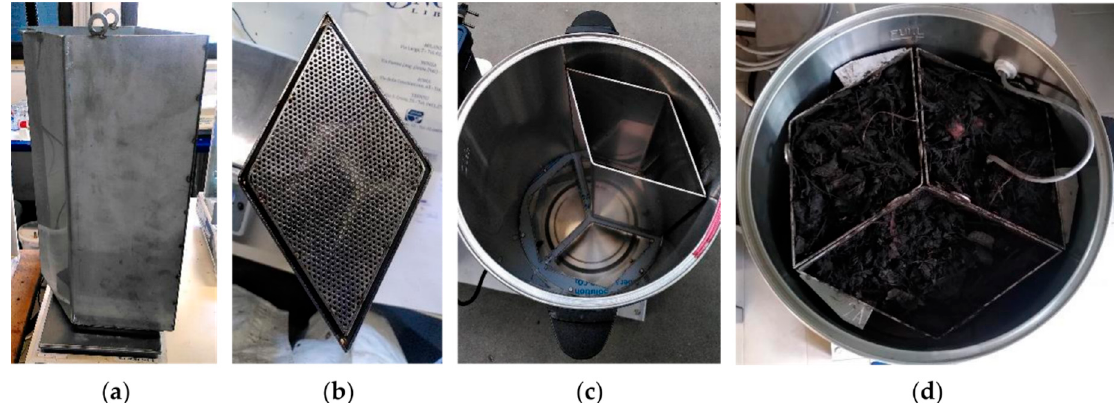
Figure 2. The internal rhombohedral sectors for triplicate co-composting test; ( a ) Lateral view of one sector; ( b ) Bottom view of the sector; ( c ) One sector put on the internal support; ( d ) Top view of the biocell, subdivided into the three sectors for triplicate tests at the same conditions, filled with the feedstock to be composted.